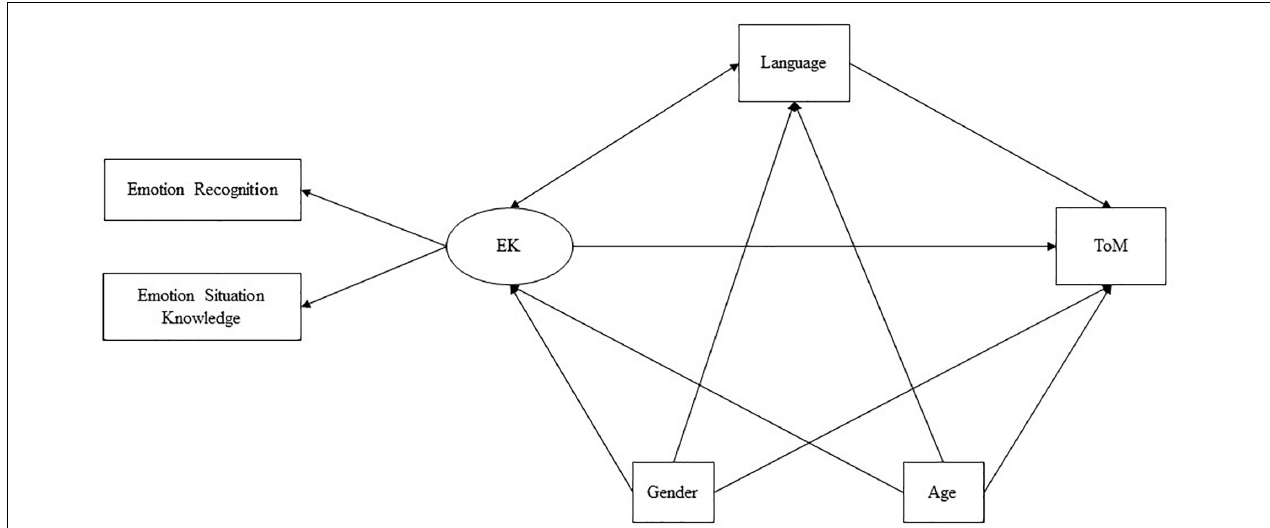
FIGURE 1 | Conceptual model of estimated patterns of association between demographic characteristics, emotion knowledge, language, and theory of mind.